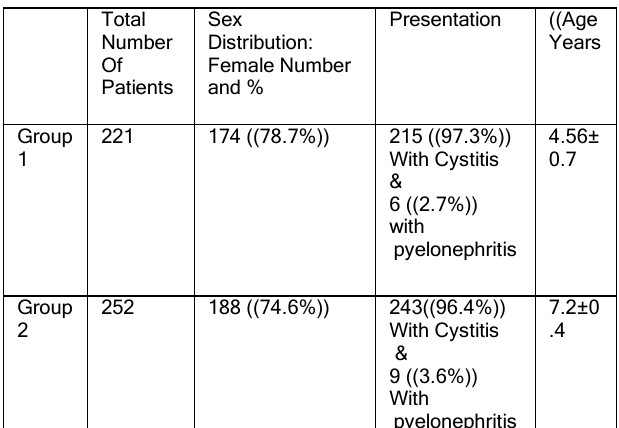
Presentation Sex